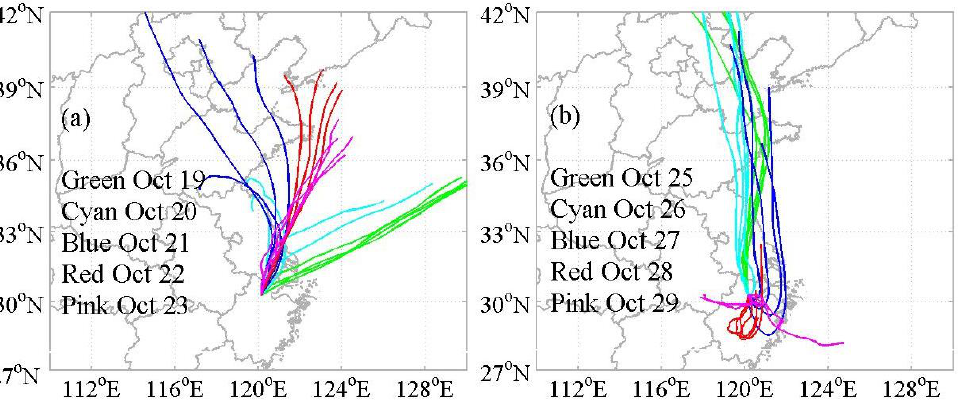
Figure 8. Forty-eight-hour back trajectories of the air masses at 500 m above ground level over Hangzhou in PE1 ( a ) and PE2 ( b ).